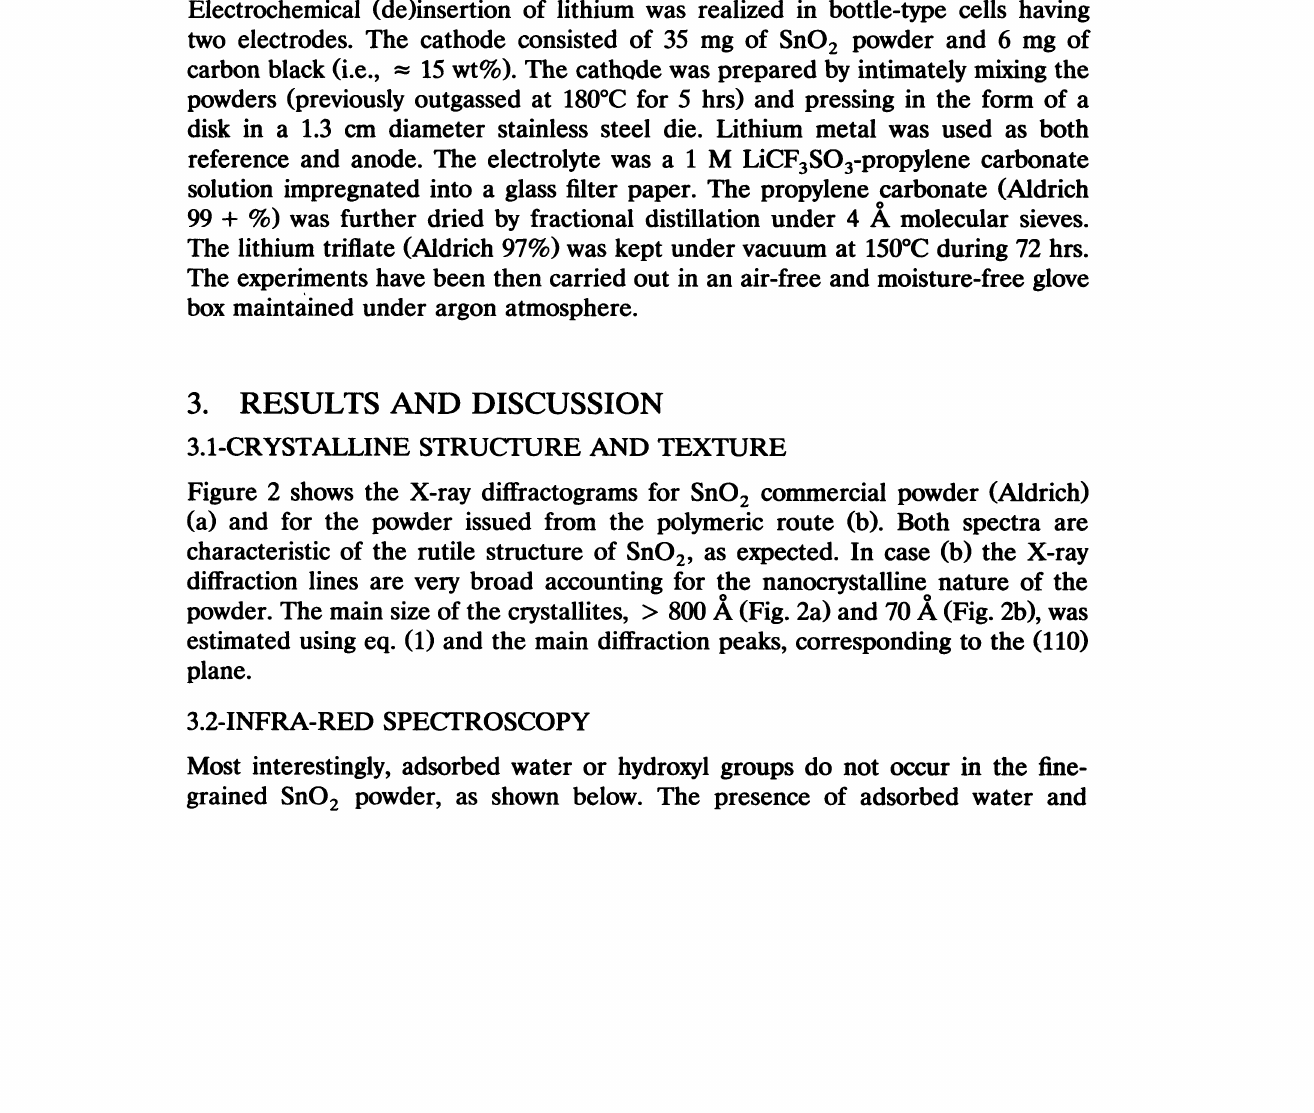
FIGURE 2 X-ray diffractograms of the SnO powders, (0): SrlO2 with larger crystal size (= 800 (b): SnO powder issued from the polymeric route (-- 70